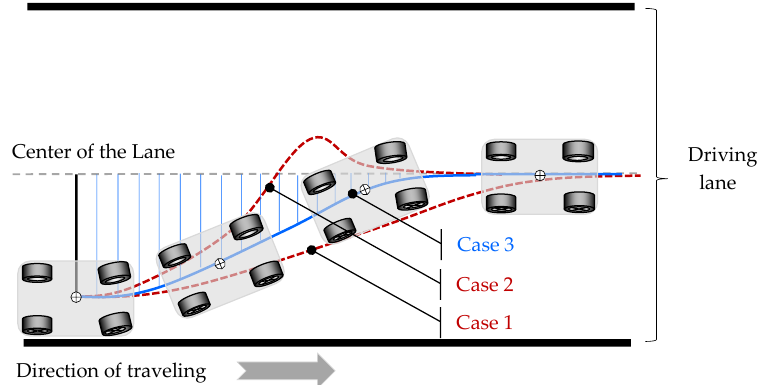
Figure 6. The three main cases of the trajectory of the car during the fitness trial: the preferred trajectory (Case 3) of the car would feature both a quick (i.e., with a narrow area under the trajectory) and oscillation-free (with a low average lateral velocity) return to the center of the lane. Case 1 and Case 2 illustrate a too-slow and a too-quick (oscillating) return to the center of the line, respectively.